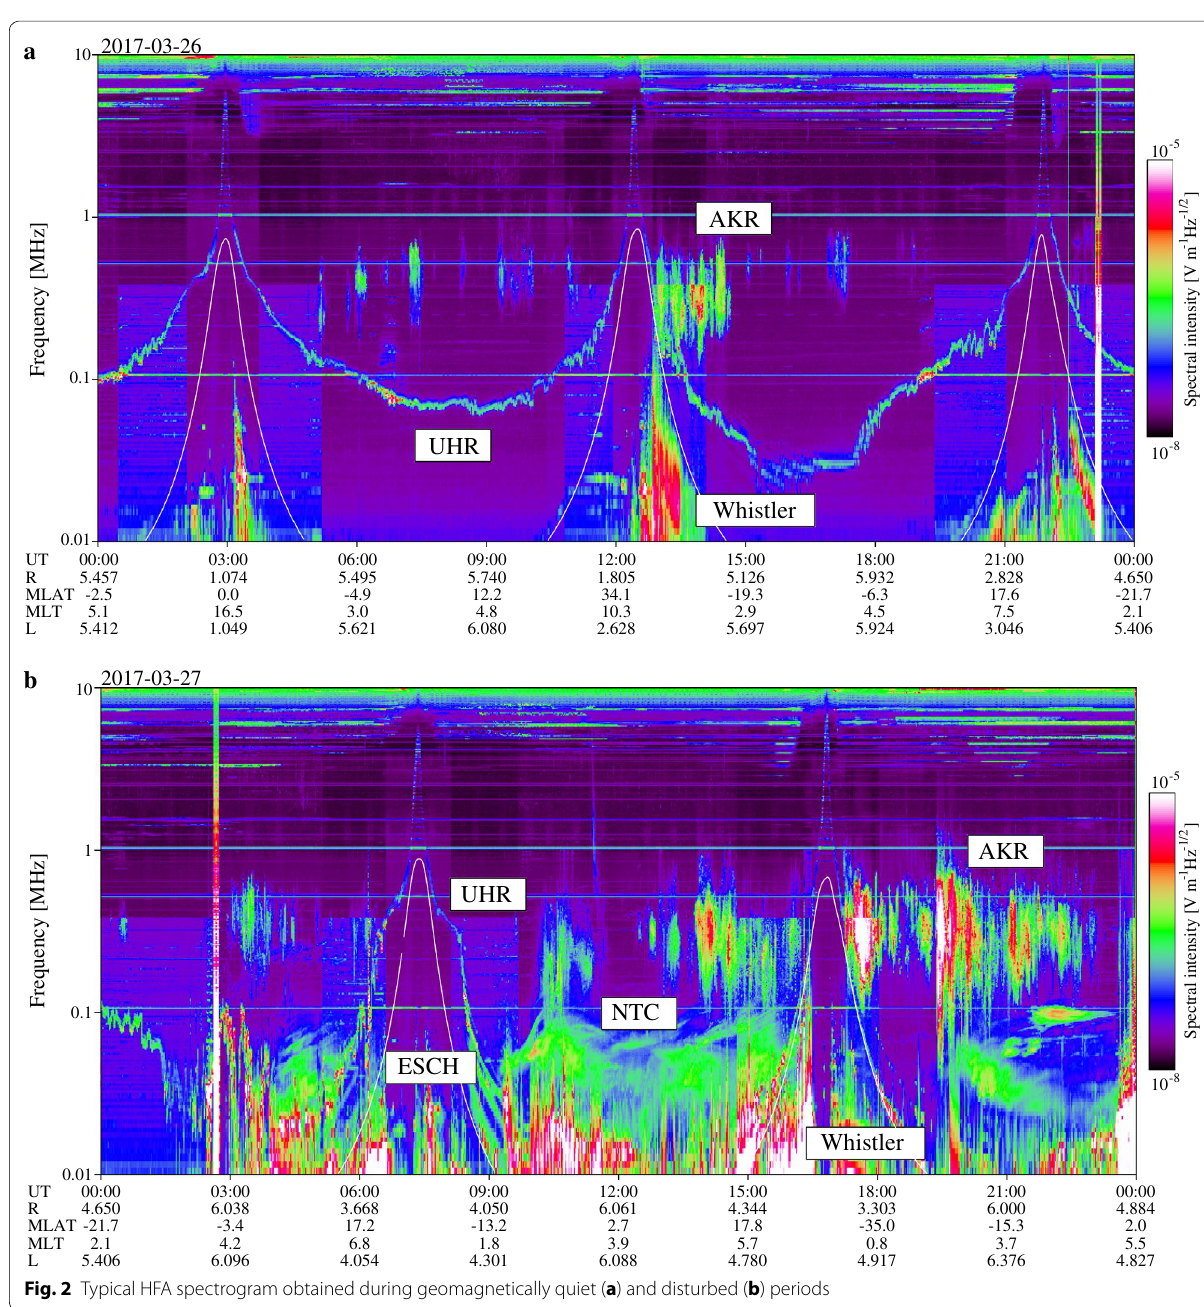
Fig. 2 Typical HFA spectrogram obtained during geomagnetically quiet ( a ) and disturbed ( b )